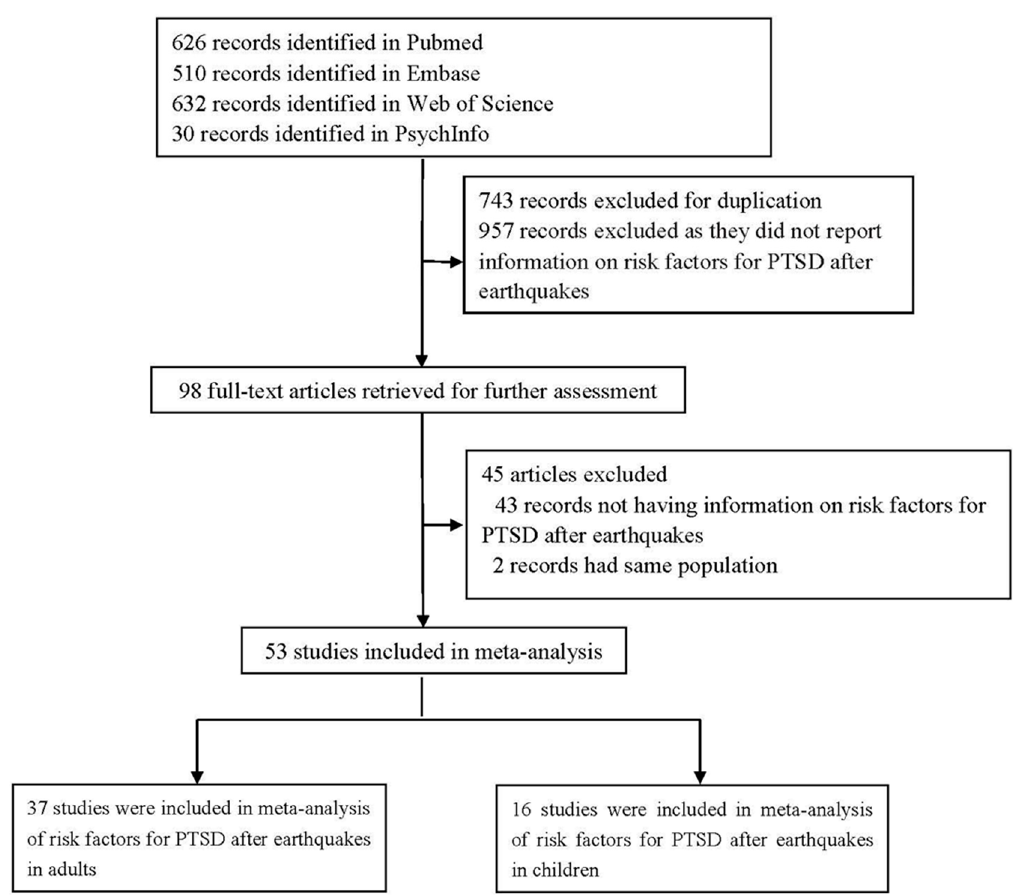
Figure 1. Search results and excluded/included studies.